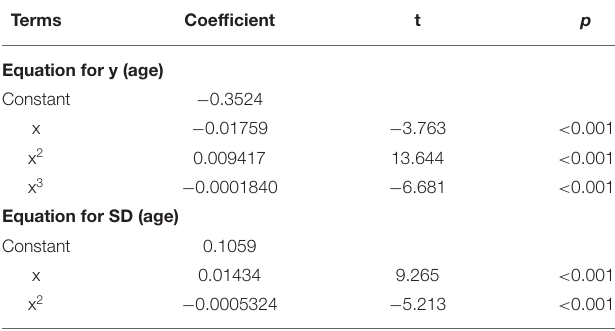
TABLE 3 | The correlated parameters of equation and result of t -test.